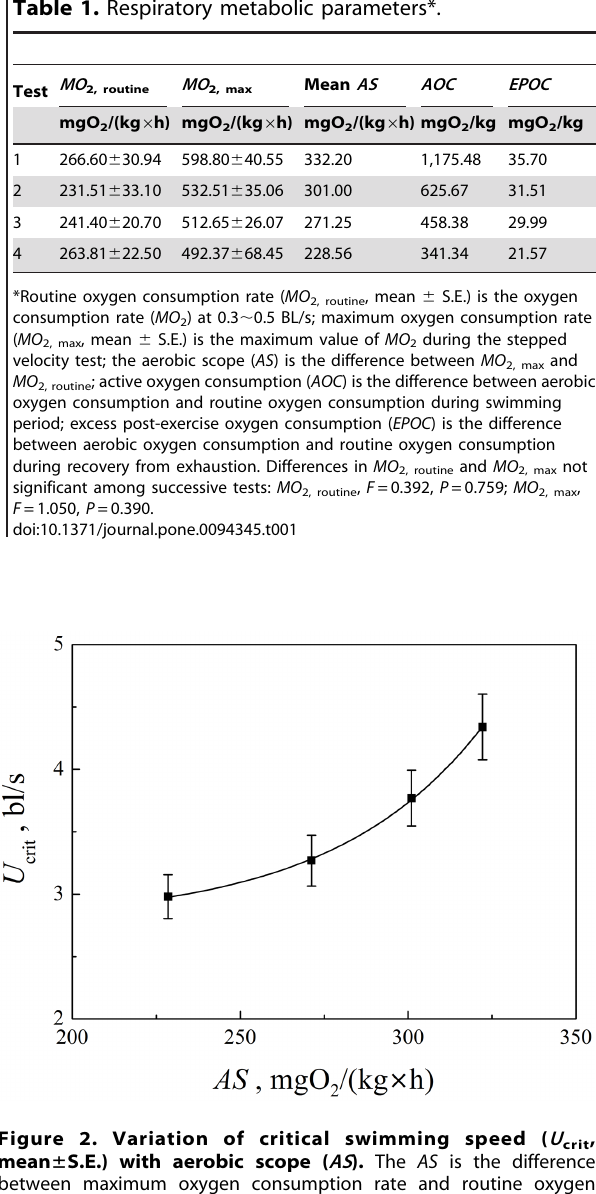
Table 1. Respiratory metabolic parameters*.